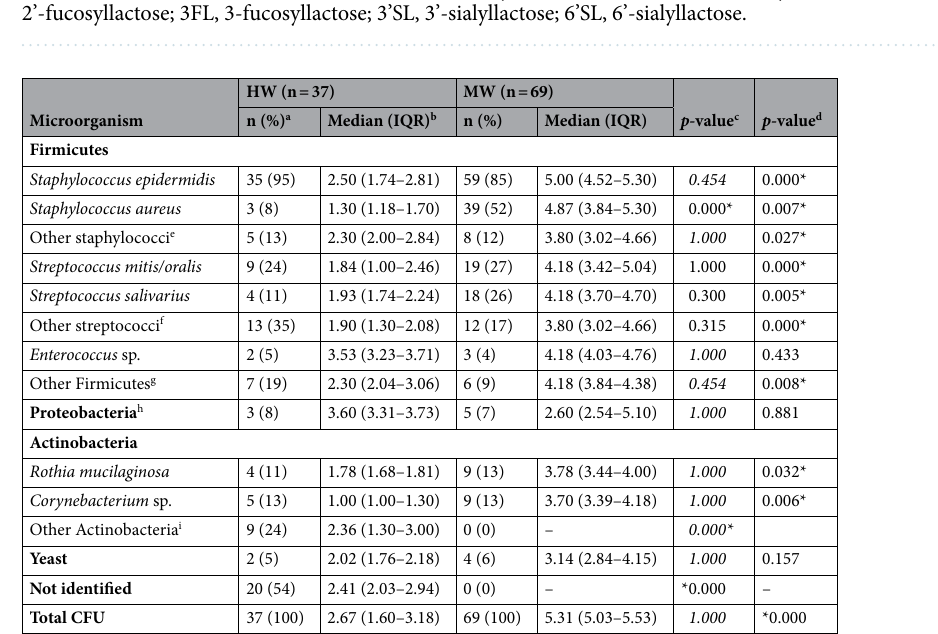
Figure 1. Spearman rank correlations between individual HMOs concentrations in milk samples from healthy women (HW group; A ) and mastitis cases (MW group; B ) groups. Only statistically significant ( p < 0.05) correlations between individual HMOs that were present in > 50% of the samples in each group are shown .The strength and colors indicate directionally (blue denotes positive; red denotes negative) of the association. DFLac, difucosyllactose; DFLNH, difucosyllacto- N -hexaose; DFLNT, difucosyllacto- N -tetrose; DSLNH, diasilyllacto- N -hexaose; DSLNT, diasilyllacto- N -tetraose; FDSLNH, fucodisialyllacto- N -hexaose; FLNH, fucosyllacto- N - hexaose; HMO, human milk oligosaccharide; LNFP, lacto- N -fucopentaose; LNH, lacto- N -hexaose; LNnT, lacto- N -neotetraose; LNT, lacto- N -tetraose; LSTb, sialyl-lacto- N -tetraose b; LSTc, sialyl-lacto- N -tetraose c; 2’FL,